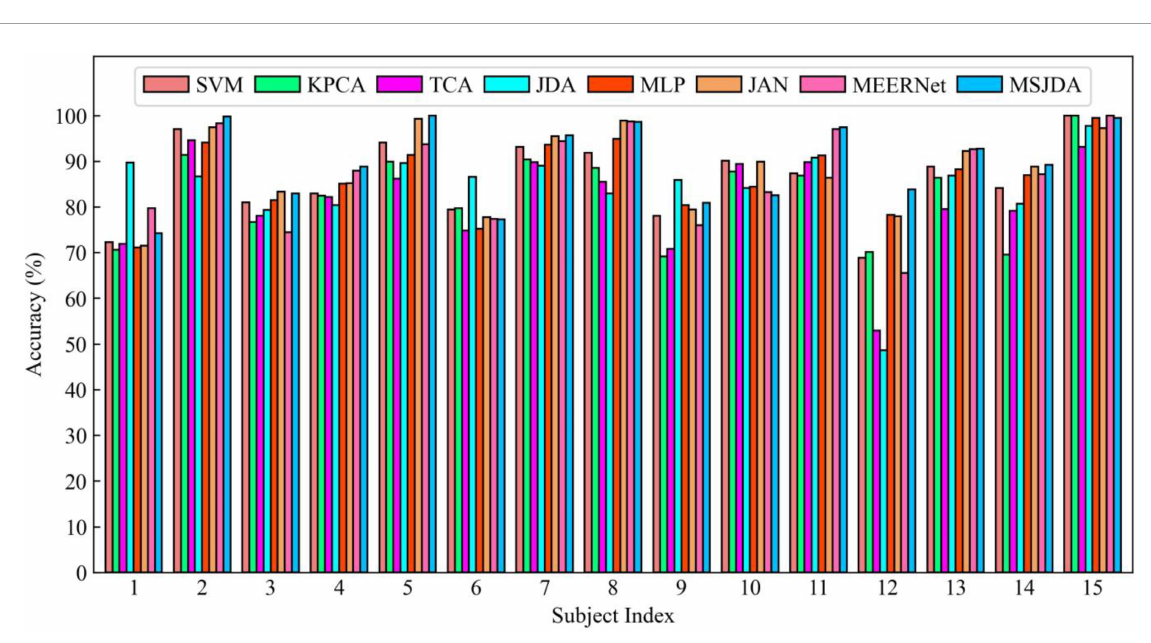
FIGURE7 Results of cross-session experiments for each subject being transferred from their respective source sessions to their second